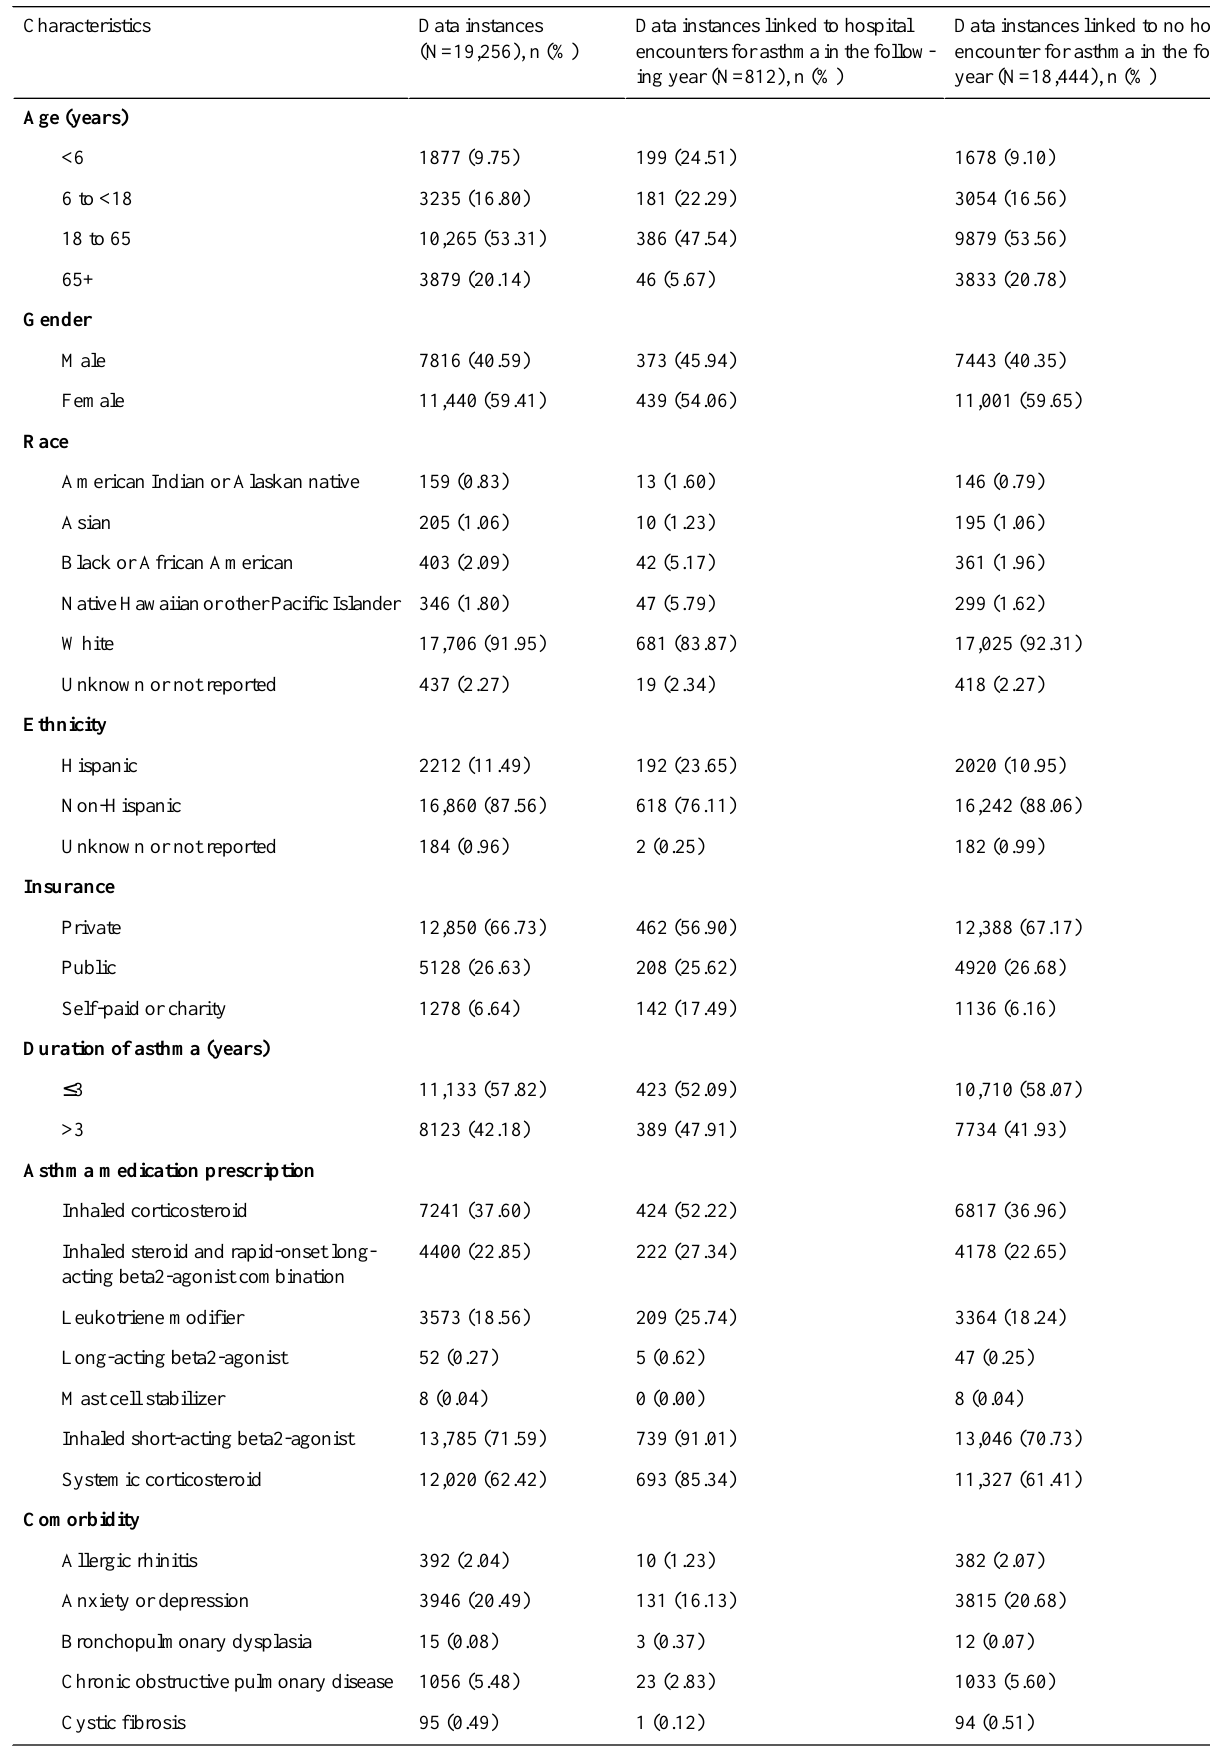
Table 3. Demographic characteristics of the asthmatic patients at Intermountain Healthcare in